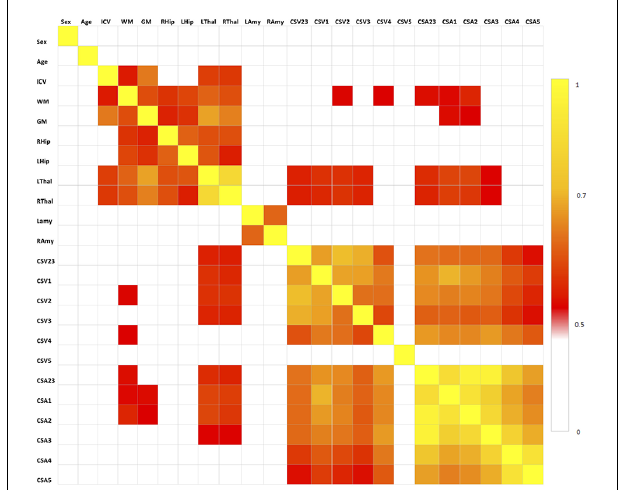
FIGURE 3 | Correlation matrix between pair of variables tested with the Spearman’s correlation coefficient. All correlations for p < 0.5 are set to white, correlations for p > 0.5 are red to yellow, with yellow ( p = 1) being the strongest correlation. No spinal cord metrics are correlating with brain metrics with p > 0.7, which is the threshold we used for extracting the set of uncorrelated features ( Table 1 ).